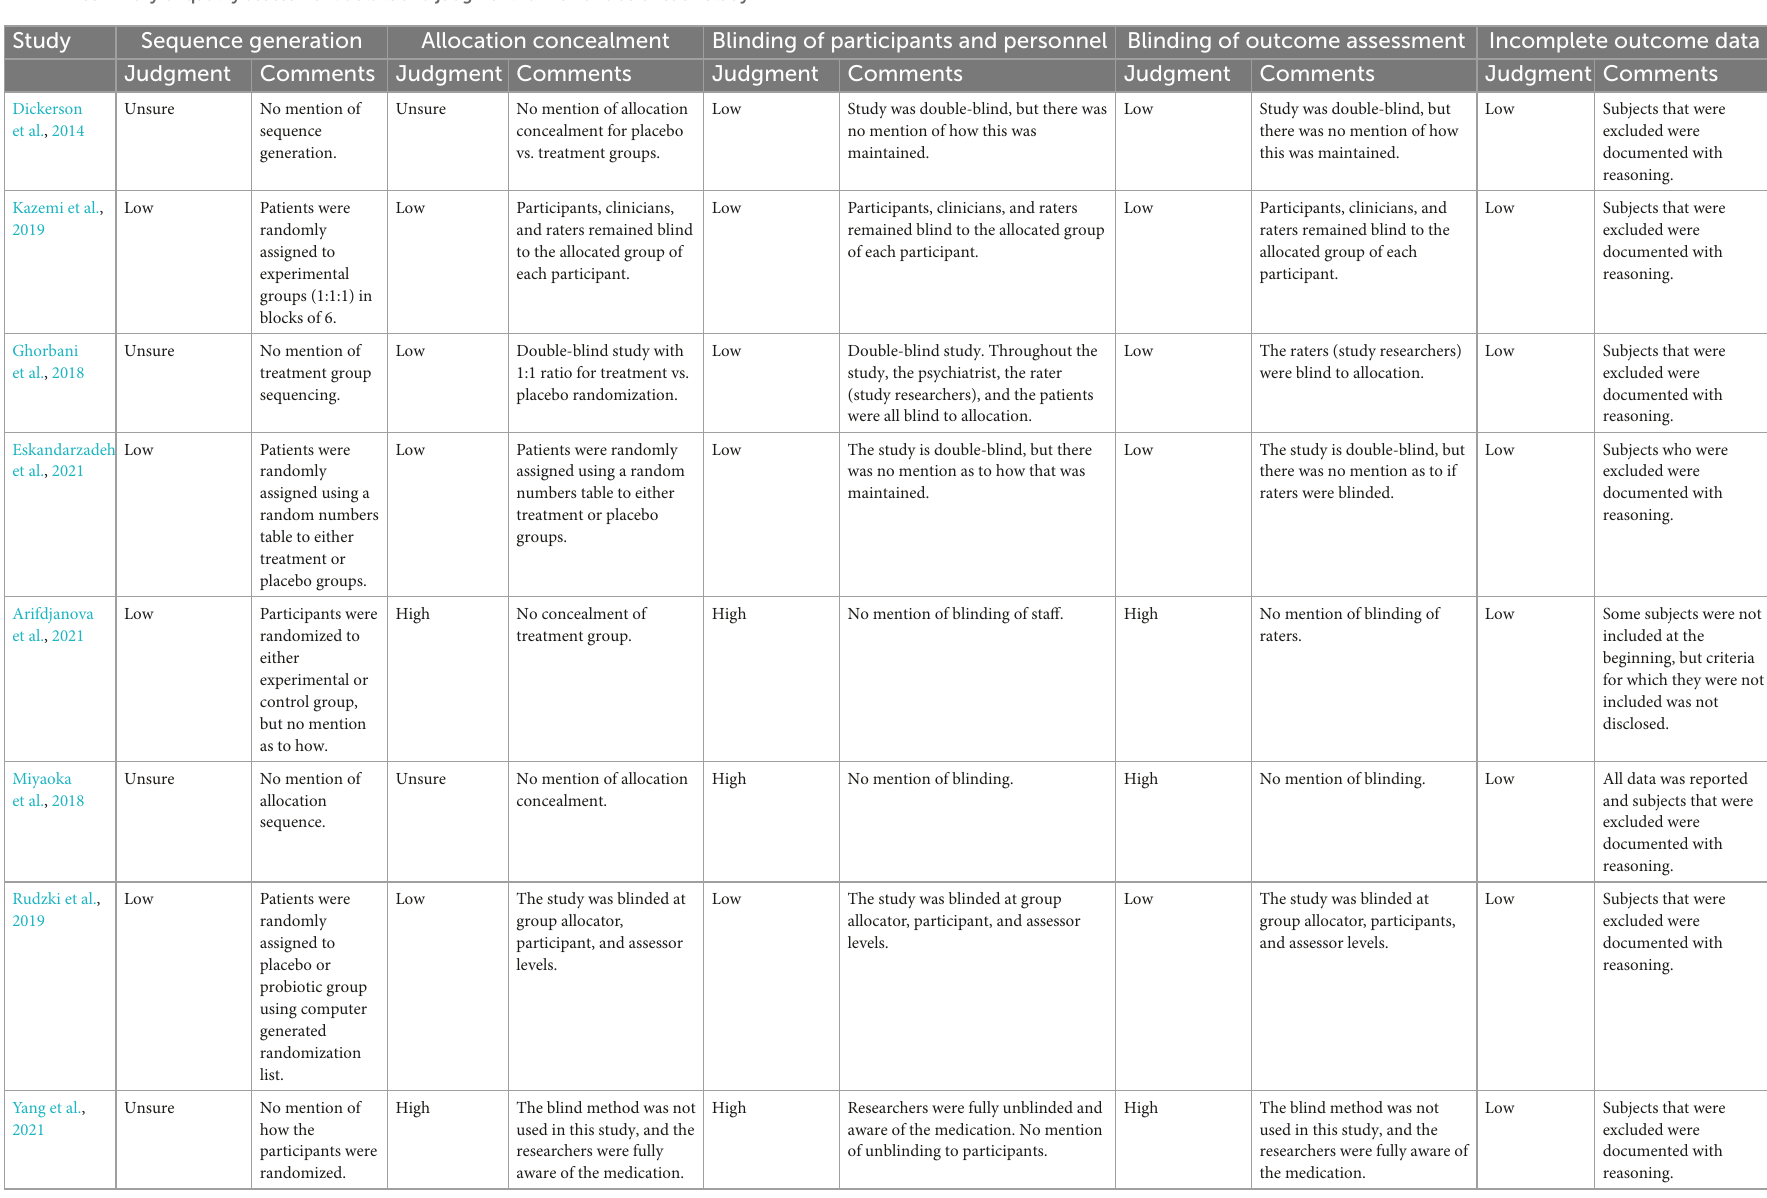
TABLE 1 Summary of quality assessment details and judgment for risk of bias of each